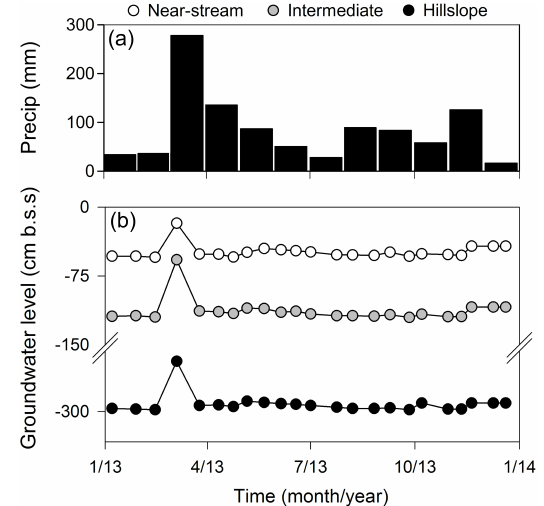
Figure 2. Temporal pattern of (a) mean monthly precipitation and (b) biweekly groundwater level at the studied riparian site during the year 2013. Circles are mean values of groundwater level at the near-stream (white), intermediate (grey), and hillslope (black) zones. Precipitation data were obtained from a meteorological sta- tion located at ca. 300m from the studied riparian site. At each ripar- ian zone, groundwater level was measured in three PVC piezome- ters (32mm diameter, 1–3m long) with a water level sensor (Ei- jkelkamp